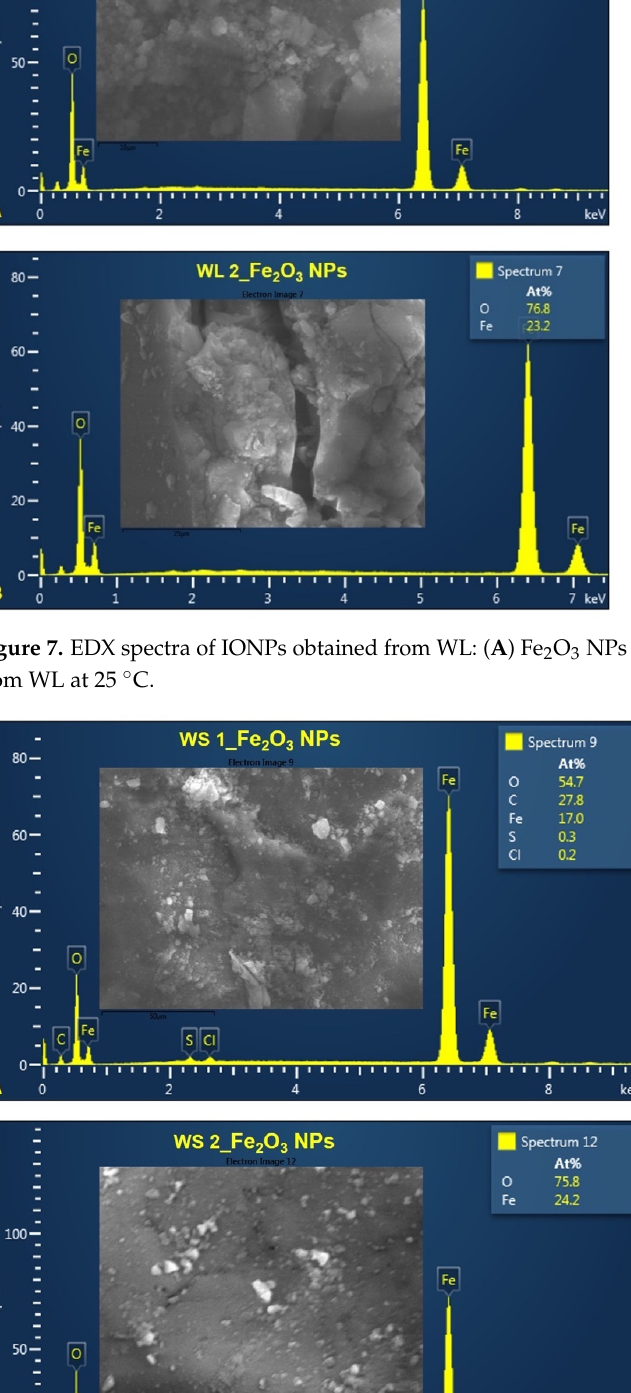
Figure 8. EDX spectra of IONPs obtained from WS: ( A ) Fe 2 O 3 NPs from WS at 80 °C, ( B ) Fe 2 O 3 NPs from WS at 25 °C.